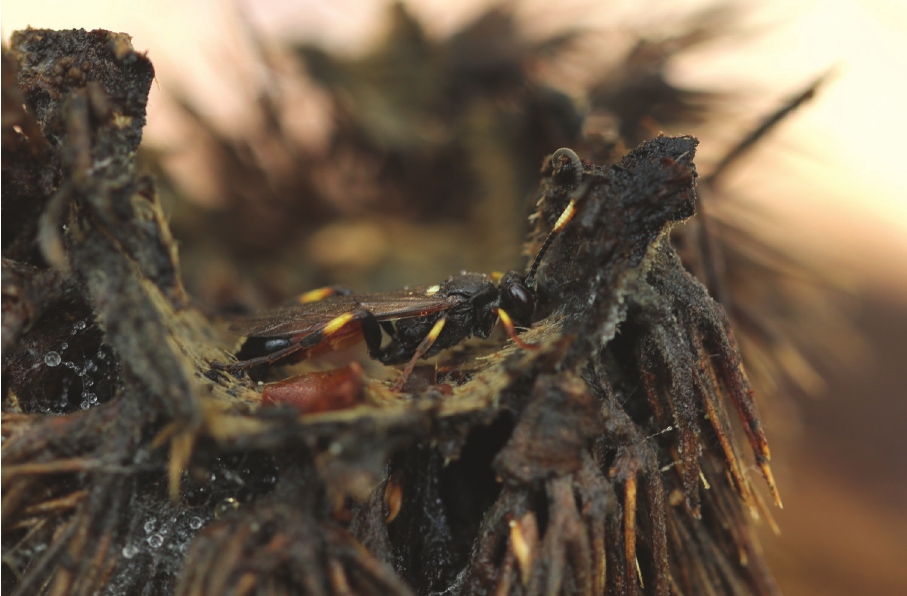
Figure 10. A female of Ichneumon suspiciosus Wesmael, 1845, found hibernating in a chestnut shell buried and turned upside down in the ground; Belgium, Proven (Theetbos), 10 October 2019. Fons